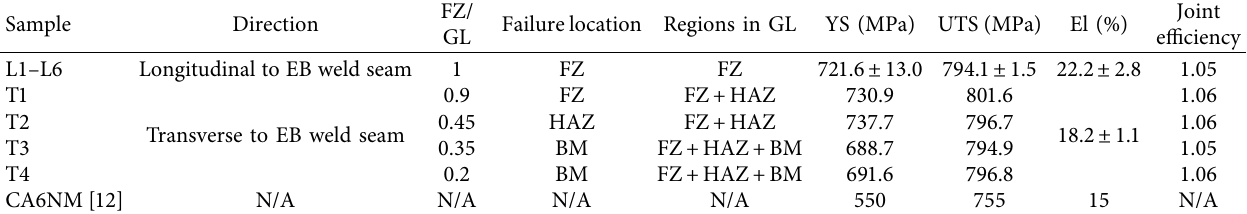
Table 3: Global tensile properties and failure locations for CA6NM